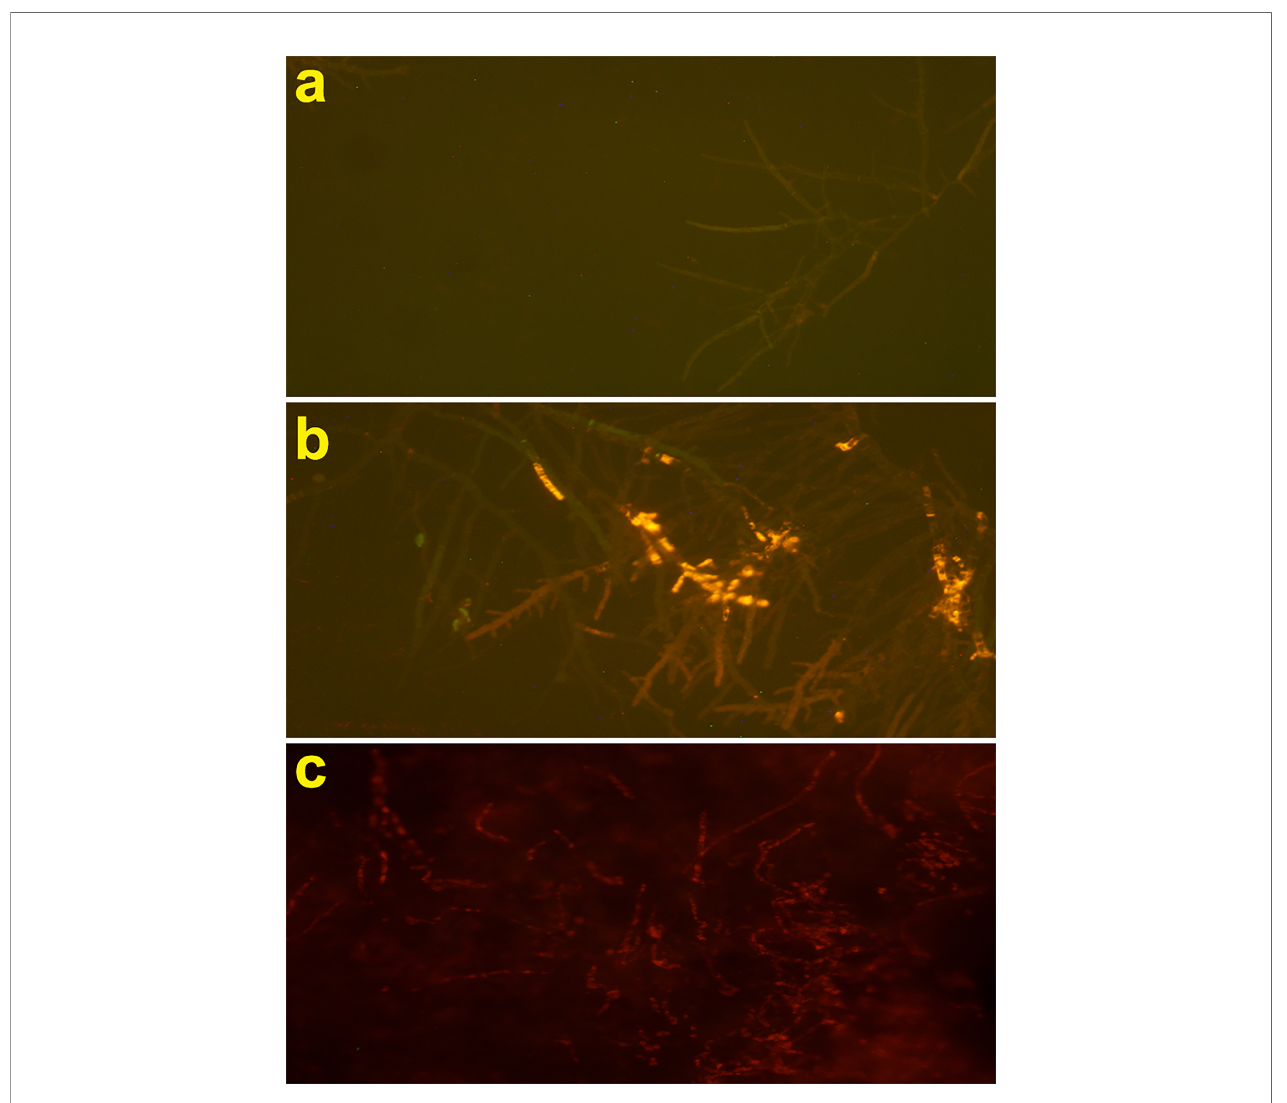
FIGURE 5 | Fluorescent microscope analysis of propidium iodide uptake during the membrane permeabilization assay. (A) Fluorescent images of untreated A. fumigatus hyphae. (B, C) Fluorescent images of treated A. fumigatus hyphae with Cc-AFP1 at the concentration of 8 and 16 m g/ml,